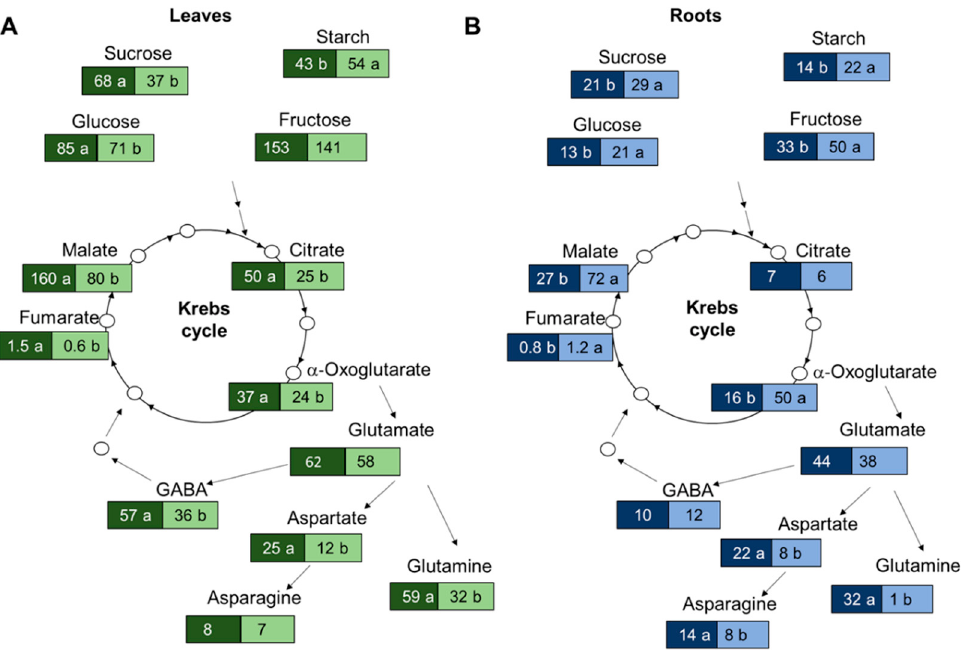
Figure 3. Effect of nitrogen supply levels on the primary metabolism. Soluble sugars and starch, organic acids, and amino acid contents (nmol/mg FW) in leaves ( A ) and roots ( B ). Metabolite contents of plants grown under 8 mM N (dark colored bars) and 4 mM N (light colored bars) conditions for 20 days. Values are means (±SE) of 3 independent determinations in different biological replicates. For each metabolite, different letters indicate significant differences ( p < 0.05).